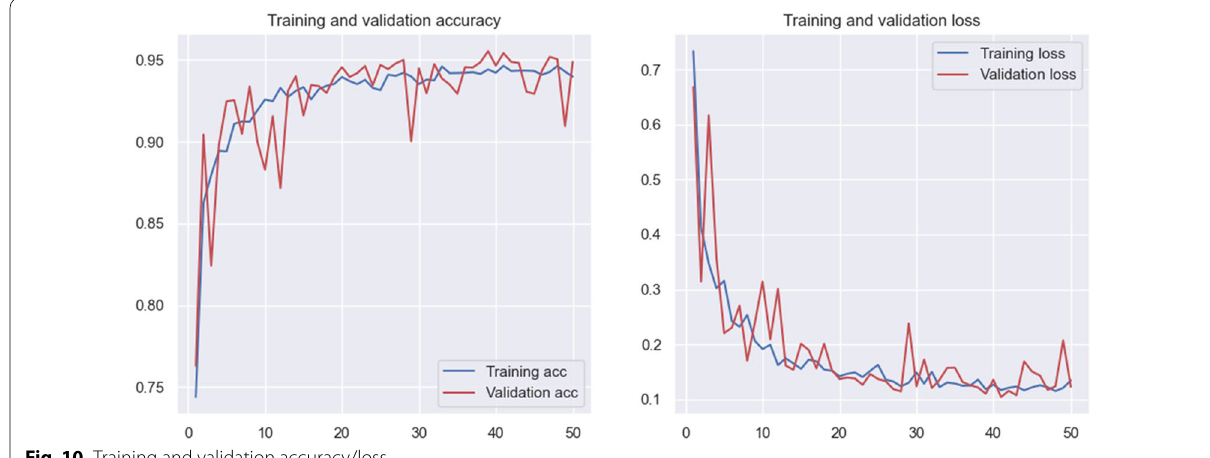
Fig. 10 Training and validation accuracy/loss